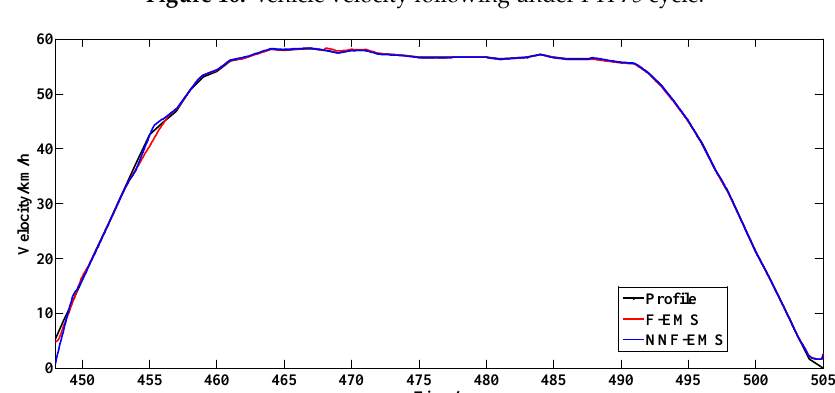
Figure 16. Vehicle velocity following under FTP75 cycle.